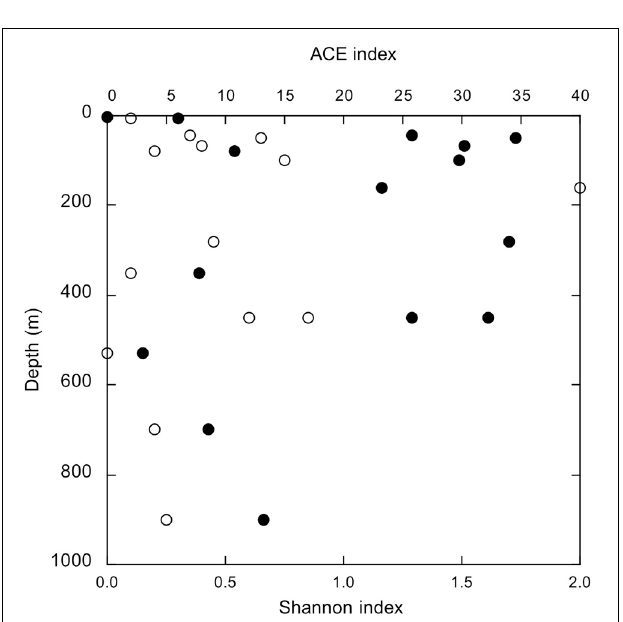
FIGURE 5 | AlkB diversity indices as a function of depth; open symbols, ACE index and closed symbols, Shannon index.